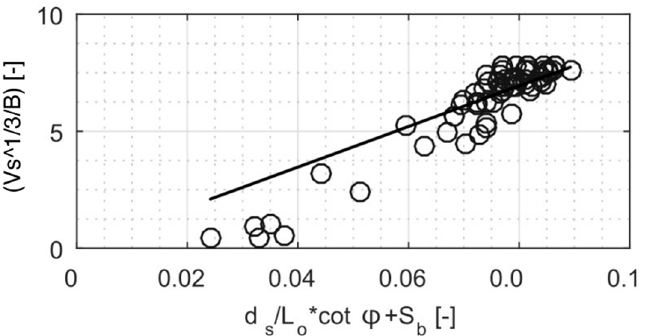
Figure 16. Normalized local scour hole volume of present experimental results versus model of local scour hole enlargement